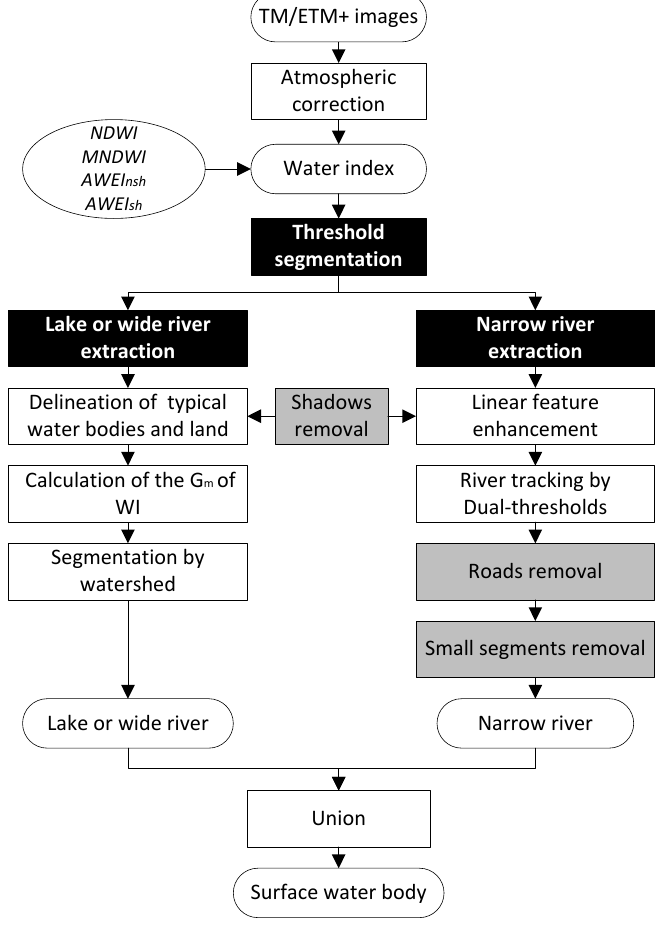
Figure 4. The automated method for extracting rivers and lakes (AMERL) scheme for extracting rivers and lakes from Landsat imagery. NDWI, normalized-difference water index; MNDWI, modified NDWI; AWEI, automated water extraction